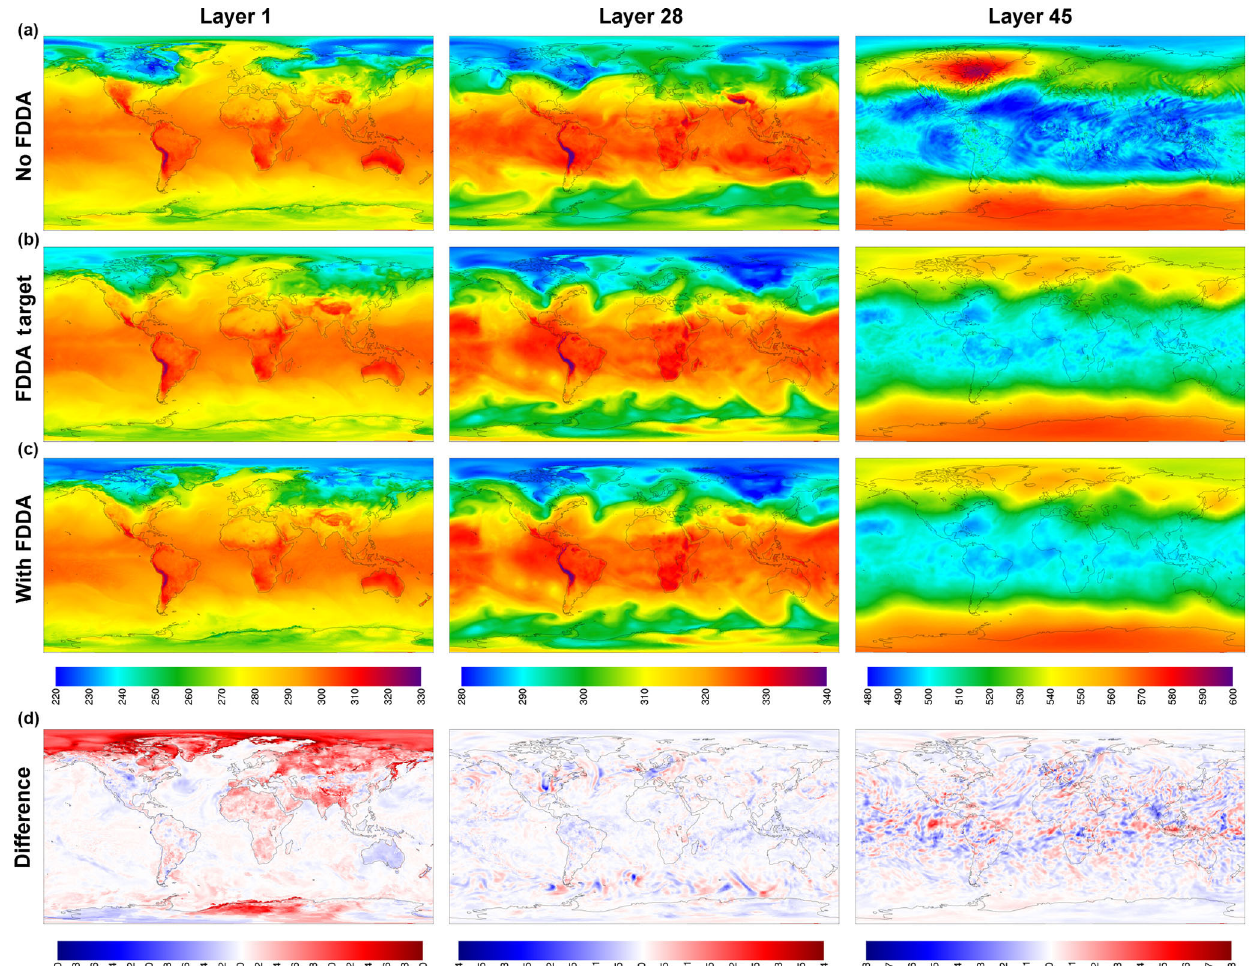
Figure 3. MPAS-A simulation results without FDDA (a) , FDDA target fields (b) , MPAS-A results with FDDA (c) , and FDDA target minus MPAS-A with FDDA (d) for potential temperature (K) in layers 1, 28, and 45, for 00:00UTC on 31 January 2013, 30 days into the